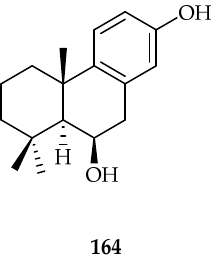
162 Figure 67. Structures of compounds 161 [105] and 162 [105] and alatavnol A 163 [106]. 3.2.6. Podocarpane-Type Diterpenoids